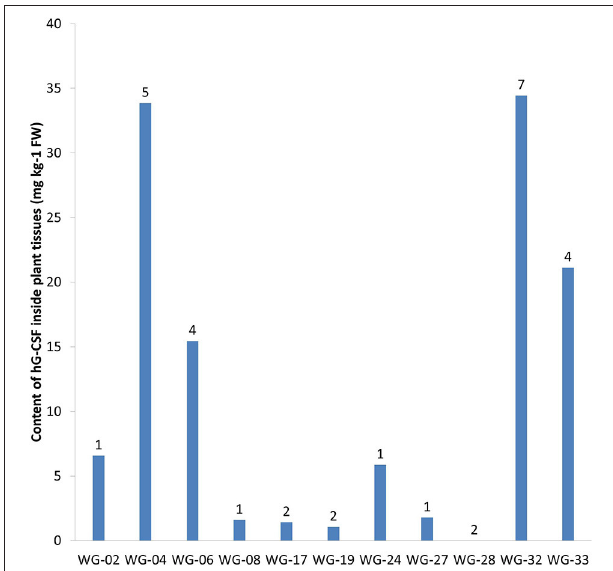
FIGURE 6 | The result of ELISA of 11 transgenic Wolffia lines containing hG-CSF gene. Numbers designate the number of hG-CSF gene insertions into transgenic line genome.